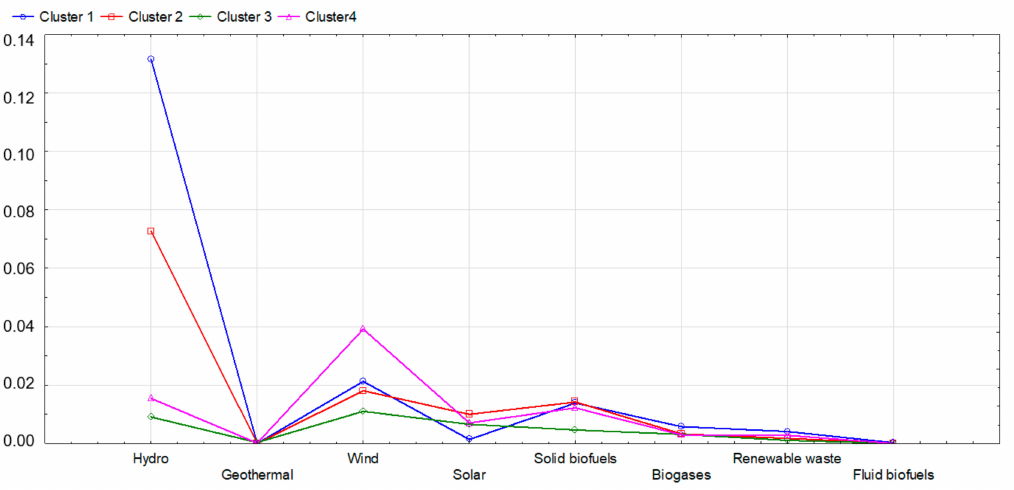
Figure 13. Mean values of energy production from renewable energy sources in relation to the value of GDP for individual clusters (own